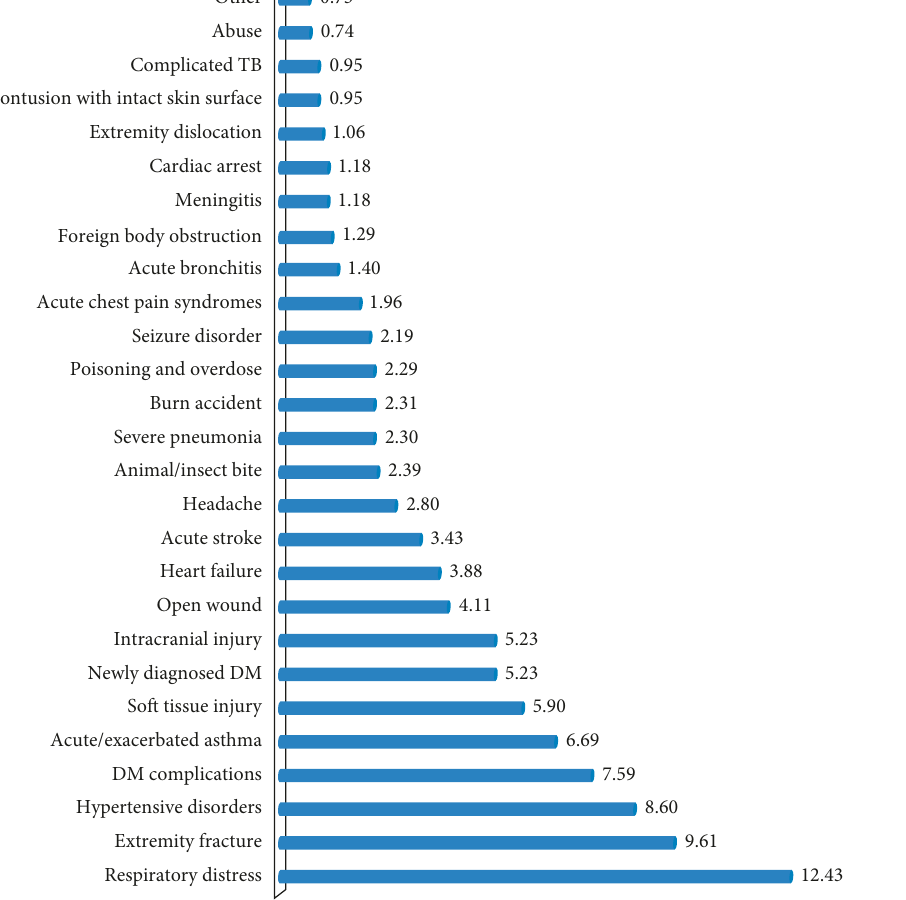
Figure 3: Leading causes of adult emergency department admission in the selected hospitals, Nekemte, Ethiopia,